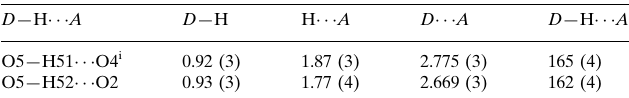
Hydrogen-bond geometry (A˚ , (cid:2)